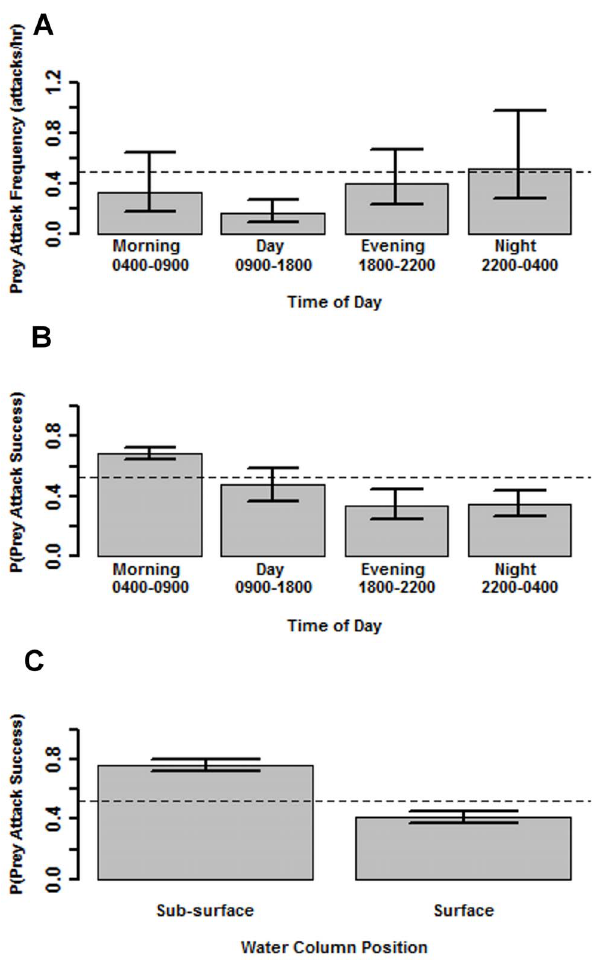
Figure 3. Alligator prey-attack frequency and prey-capture success. Estimated effects of A) time of day (Morning [0400–0900], Day